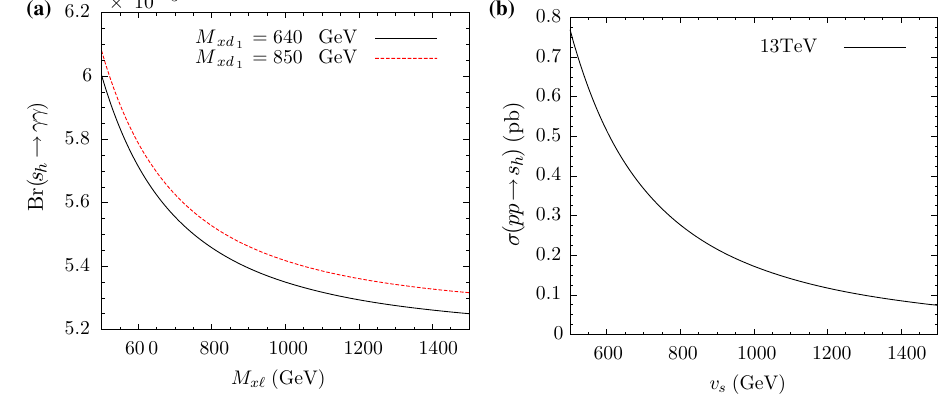
= 600 GeV. For the above plots, we fix M = M = v s with m s h xd 2 xd 3 = 1. For a M = M = M = M 1.5 TeV, y SL x (cid:14) 1 x (cid:14) 2 x (cid:14) 3 x (cid:14) , while for ii